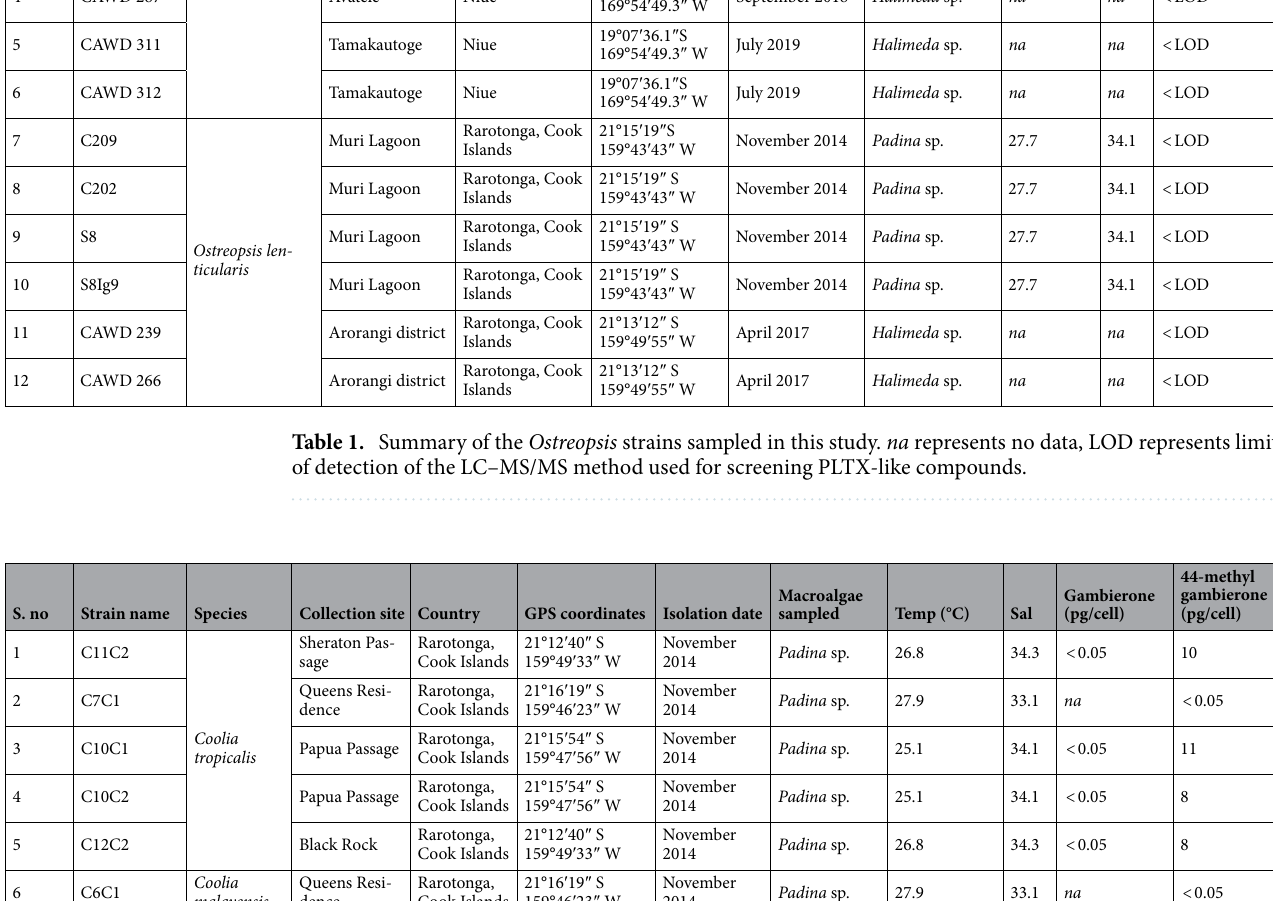
Ostreopsis lenticularis Y.Fukuyo. The photosynthetic cells were anterio-posteriorly flattened, lenticular, broadly ovate (drop-shaped) to almost round and ventrally tapering in apical and antapical views (Fig. 5). The field samples measured 78.1–87.5 μm in depth (n = 12), and 55.5–82.9 µm in width (n = 12). The mean DV:W ratio was 1.24 (1.0–1.57, n = 12). The nucleus was located dorsally (Fig. 5A,D). One or two pusules were recorded (Fig. 5B,D,E). The thecal plate pattern was: APC 3 ′ 7 ′′ ?c ?s 5 ′′′ 2 ′′′′ (Figs. 6 and 7). The slightly curved and elon- gated apical pore complex (APC) was located parallel to the left dorsal cell margin (Fig. 6C,D,G). The apical (or outer) pore plate (Po) was about 11.5–18.0 µm long (n = 7). The first apical plate (1 ′ ) was long, hexagonal and most of it located left to the centre of the epitheca (Fig. 6B–F). The second apical plate (2 ′ ) was narrow and slightly longer as the Po plate (Fig. 6D,G). The third apical plate (3 ′ ) had a short suture with the Po plate (Fig. 6B–D,G). In the precingular series plate 1 ′′ was the smallest and 6 ′′ the largest (Fig. 6A–F). The suture between plates 2 ′′ and 3 ′′ was located at about half Po plate length (not shown). Plate 5 ′′ was not in contact with plate 1 ′ (Fig. 6A,B,D). The cingulum was narrow, deep, and not undulated (Fig. 6A,C–F). Cingular and most sulcal (Fig. 7B) plates were not observed. The postcingular plate series consisted of a small first (1 ′′′ ) plate and four large plates (2 ′′′ -5 ′′′ ) (Fig. 7A,C,D). The two antapical plates were of unequal size, 1 ′′′′ smaller and 2 ′′′′ being asymmetrical and relatively large (Fig. 7A,C,D). The left side of the posterior sulcal plate (Sp) was in contact with the 1 ′′′′ plate and its posterior end with the 2 ′′′′ plate (Fig. 7B). Thecal plates were smooth with scattered large pores (0.35–0.51 µm in diameter, n = 20) and small pores (0.06–0.08 µm in diameter, n = 19) (Fig. 8A–C). Large